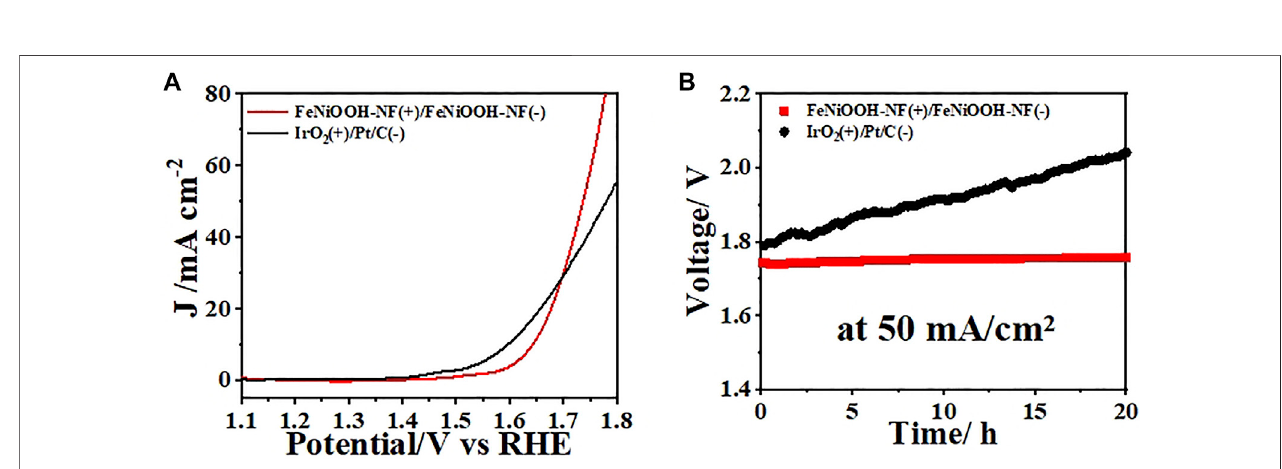
FIGURE 5 | (A) Steady-state polarization curves for overall water splitting of bifunctional FeNiOOH-NF electrodes and IrO 2 -NF and Pt/C-NF benchmark. (B) Chronoamperometry tests of FeNiOOH NF eletrodes and IrO2-NF and Pt/C-NF benchmark at a current density of 50 mA cm − 2 for 20 h.